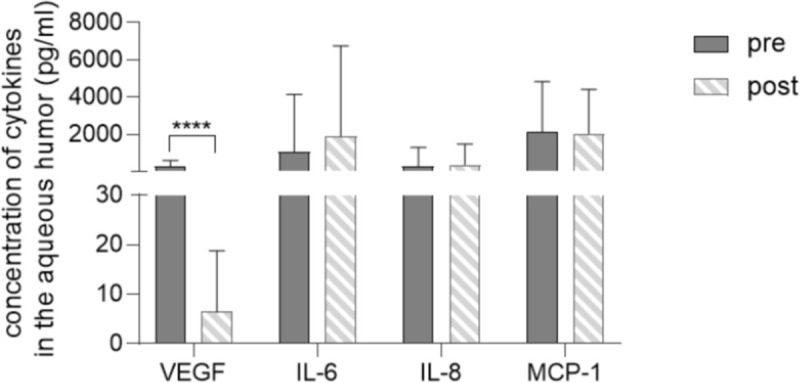
Level of cytokine pairs in the aqueous humor before and after intravitreal injection of bevacizumab.(****: P<0.0001).